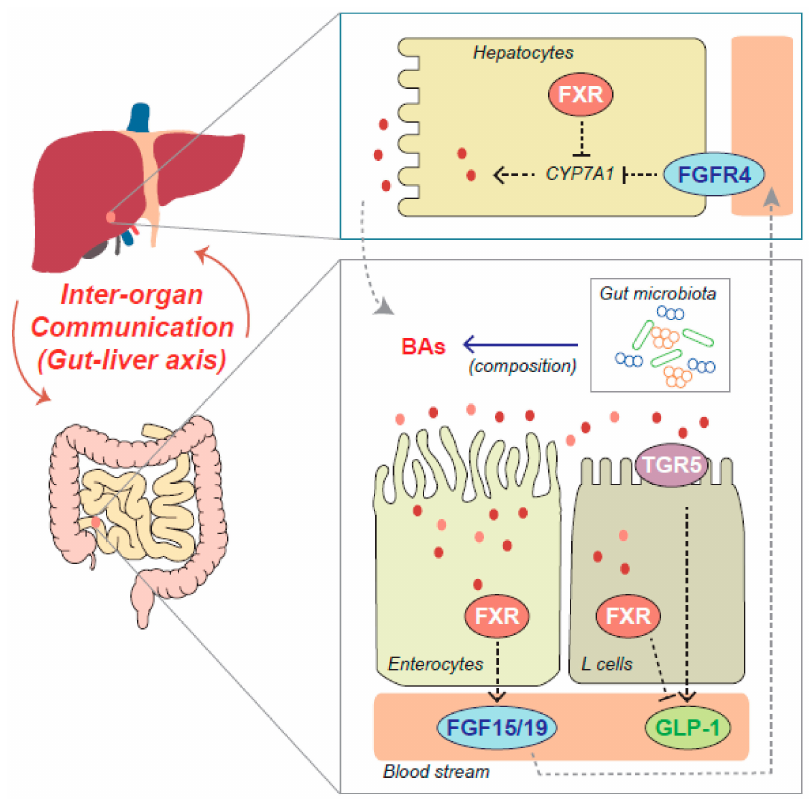
Figure 2. The roles of FXR in the gut–liver axis. FXR contributes to the crosstalk between liver and intestine through the regulation of hepatic bile acids (BAs) synthesis and intestinal fibroblast growth factor-15/19 (FGF-15/19) secretion. FGF15/19 controls the BA production via hepatic FGF receptor 4 (FGFR4) signaling. BAs act on TGR5 as well as FXR, contributing to metabolic homeostasis. Intestinal microbiota affects the composition of BAs, leading to changes in FXR activities. Dotted gray arrows represent the transport of BAs or FGF15/19 through the bile duct or the portal vein, respectively. Dotted black arrows indicate the activating effects, whereas dotted T bar arrows indicate the inhibitory effects. Solid blue arrow represents the effects of gut microbiota on the composition of BAs, while red arrows represent the inter-organ crosstalk between liver and